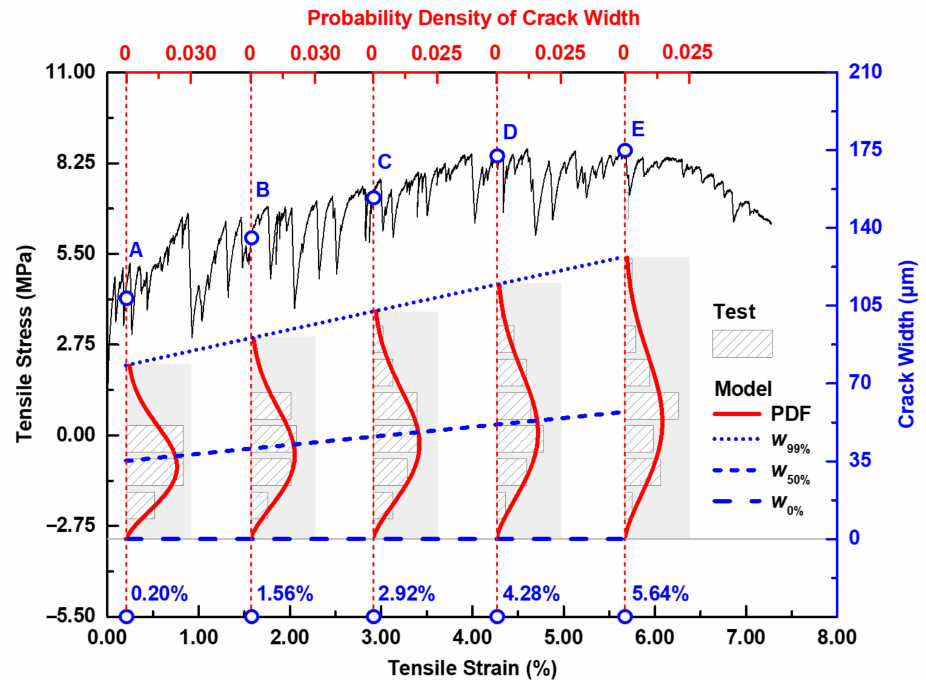
Figure 8. Model and test results of crack width distributions of strain-hardening UHPC with PE fibers at different tensile strain levels. (Reproduced with permission from